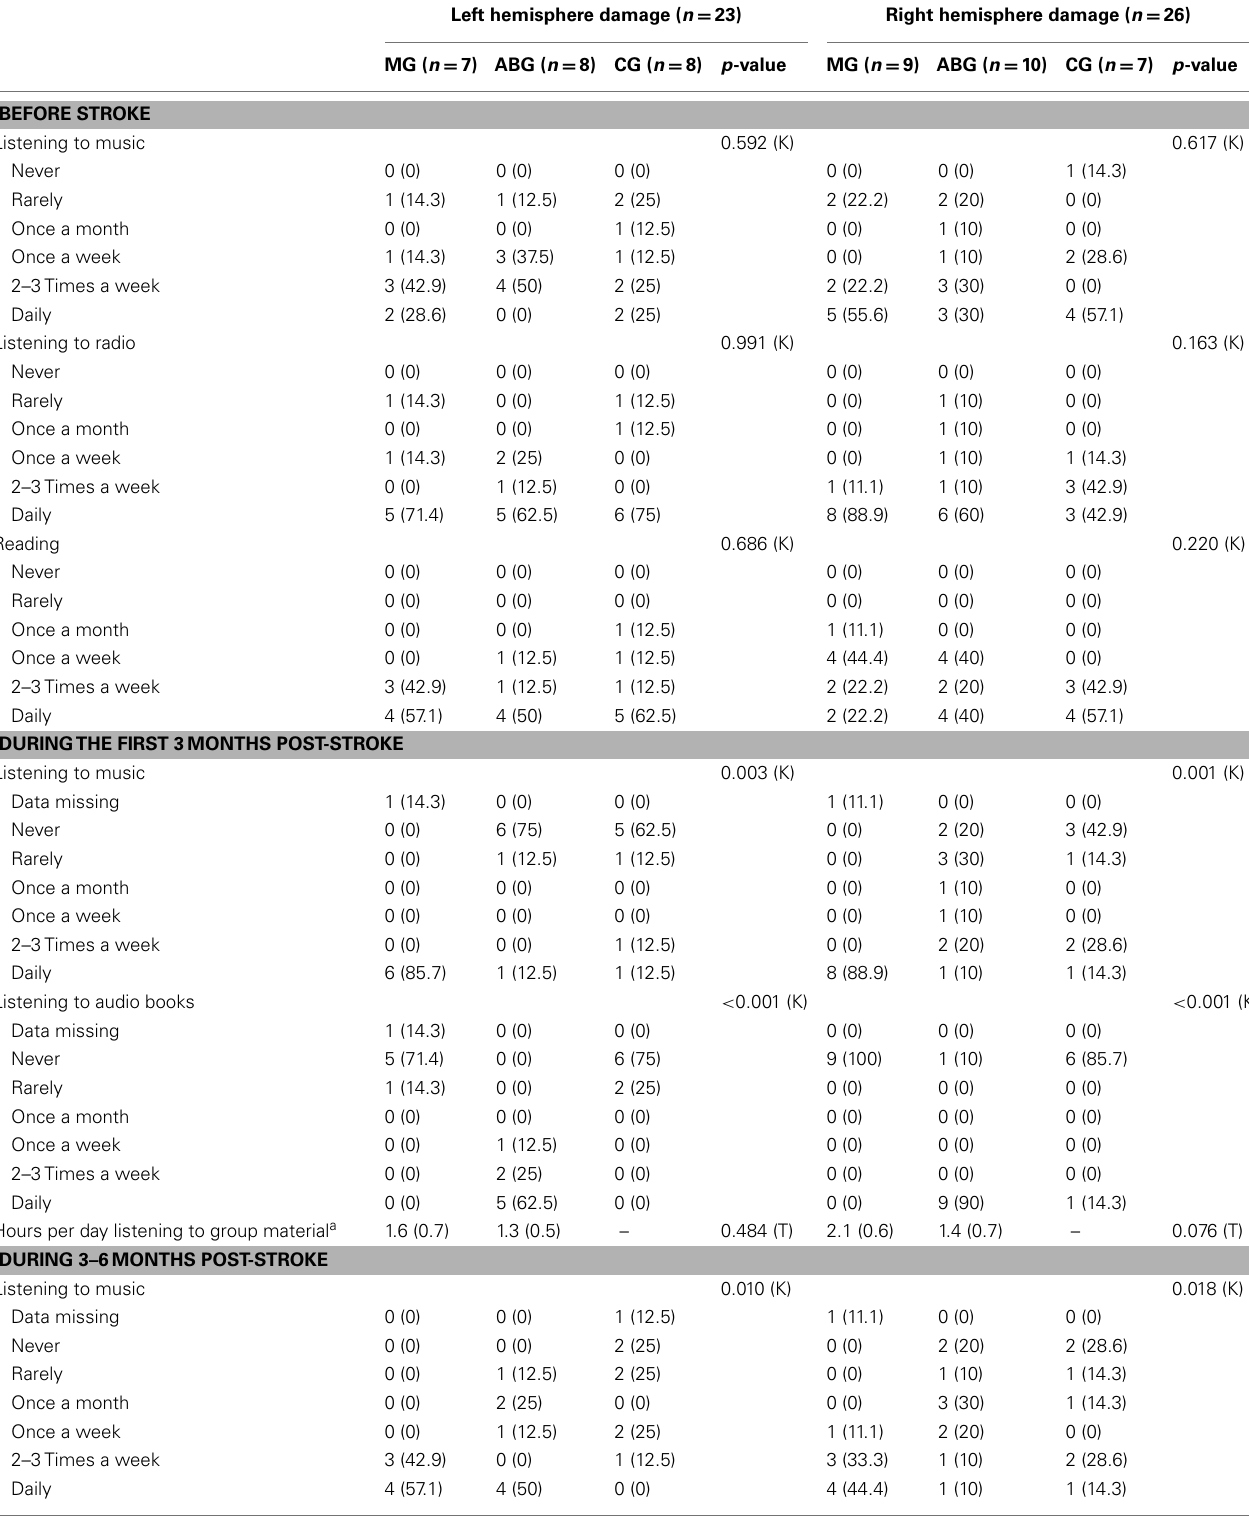
Table 2 | Musical and linguistic activities of the patients ( n =